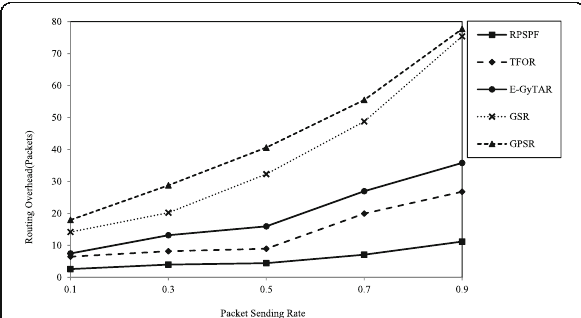
Fig. 10 Routing overhead as a function of the number of nodes (in 5 packet/s). RPSPF represents Reliable Path Selection and Packet Forwarding Routing Protocol which is proposed approach and is represented by a solid line with a square. TFOR is traffic flow- oriented routing protocol and is represented by a dashed line having rhombus. E-GyTAR is Enhanced Greedy Traffic Aware Routing protocol and is represented by a solid line with circle. GSR is geographic source routing protocol and is presented by a dotted line having a cross. GPSR is Greedy Perimeter Stateless Routing Protocol and is presented by a dashed line having a triangle